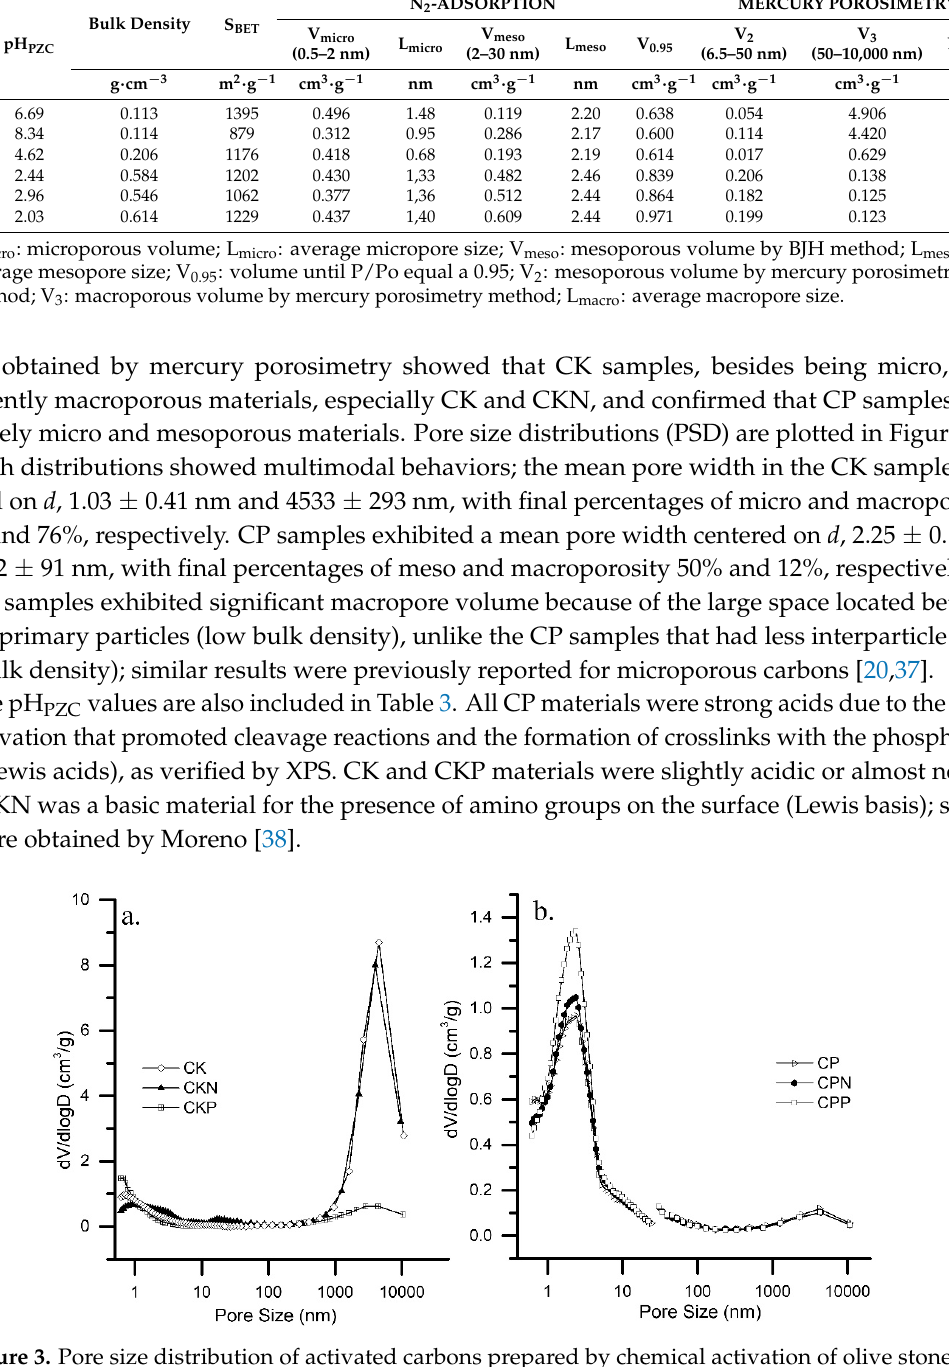
Figure 3. Pore size distribution of activated carbons prepared by chemical activation of olive stones with ( a ) potassium hydroxide (CK) and ( b ) phosphoric acid (CP) functionalized with melamine (CKN and CPN), and phosphoric acid (CKP and CPP).